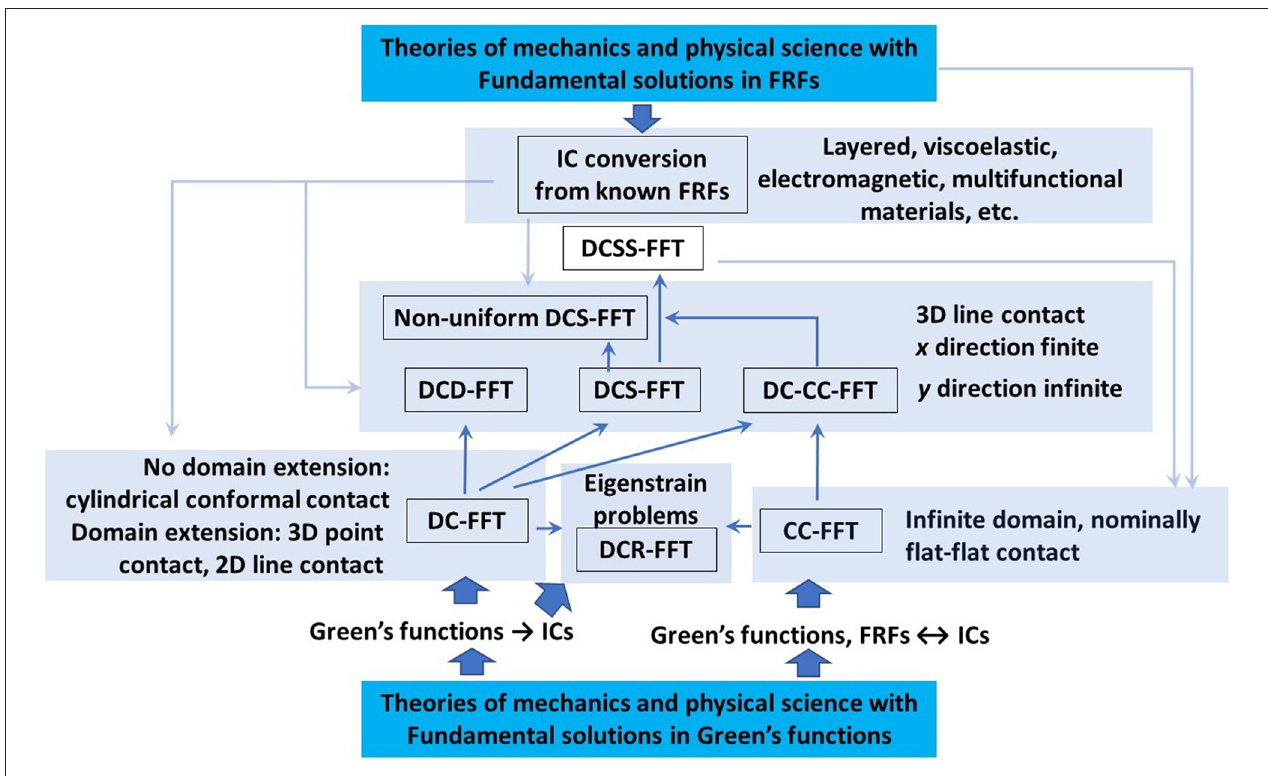
FIGURE 13 | FFT algorithm tree and the application field (light blue) of each. The darker arrow lines indicate the paths of method development while the lighter arrow lines means IC-FRF conversions and information supplies.